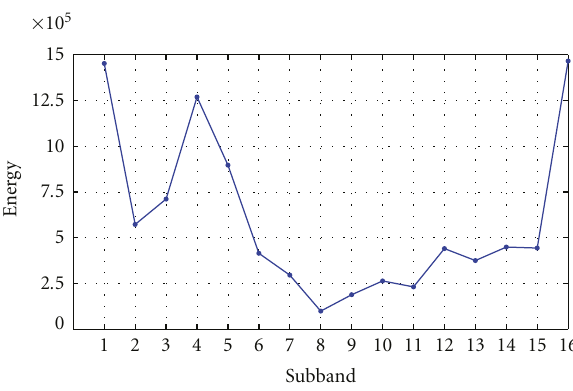
Figure 5: Energy variation in the last